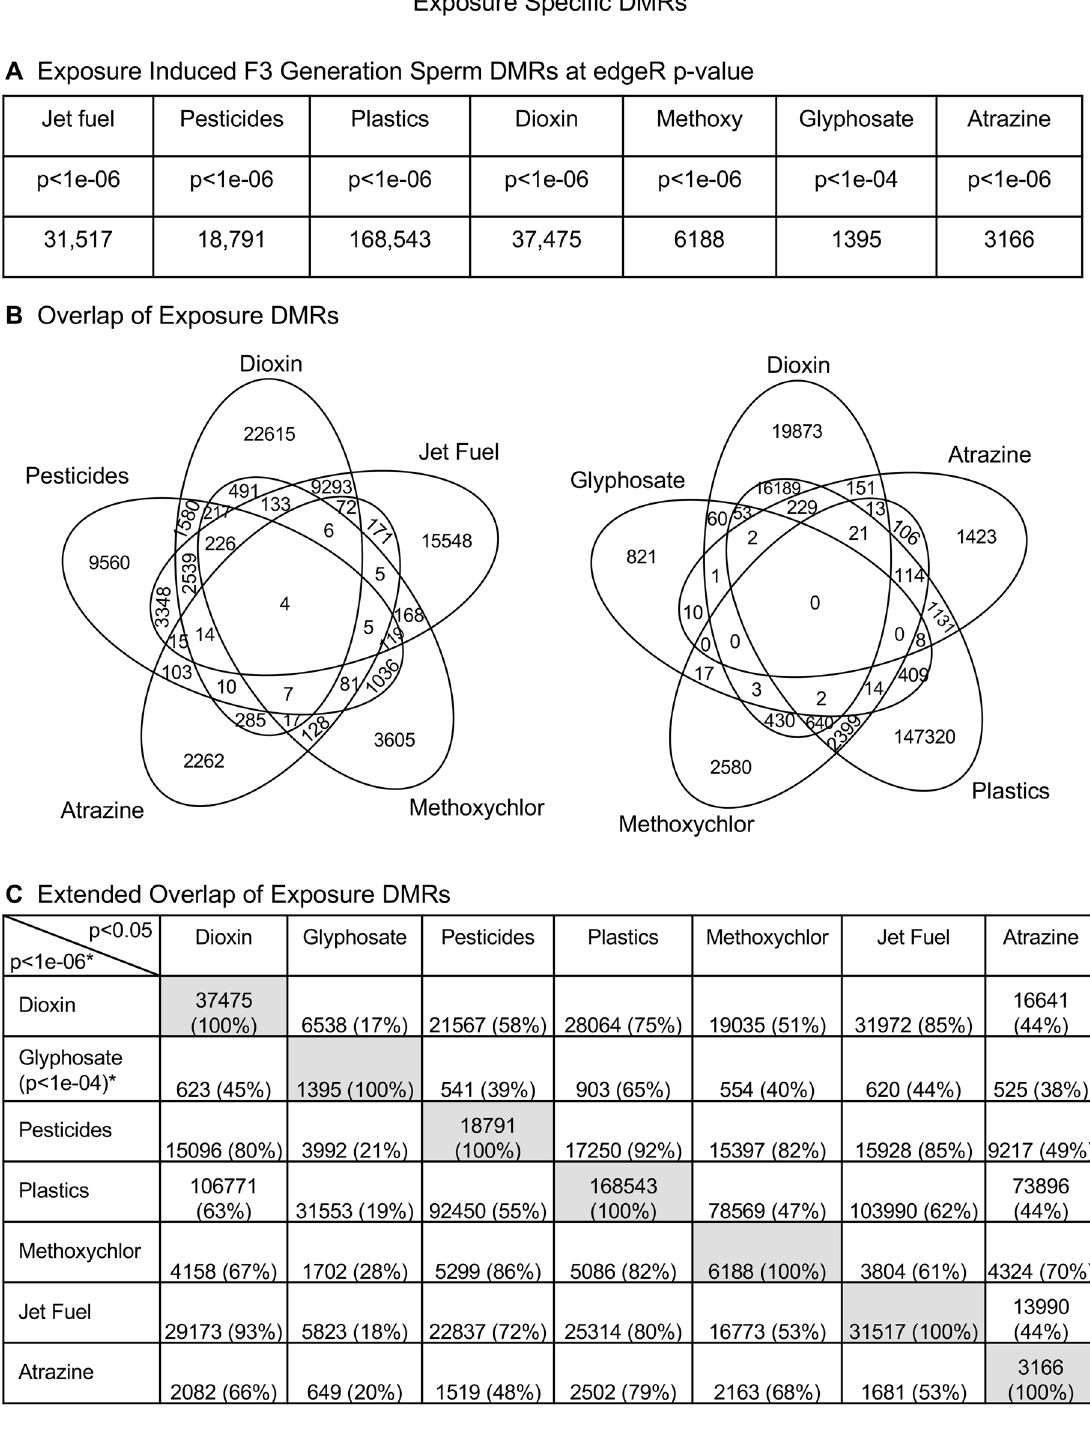
Figure 1. Exposure specific DMRs. ( A ) Exposure DMRs at using a p < 1e−6 edgeR p value threshold for everything except glyphosate at p < 1e−4. ( B ) Overlap of Exposure DMRs ( p < 1e−06), *except glyphosate at p < 1e−04. ( C ) Extended Overlap of Exposure DMRs. The overlapping DMRs and percent overlap are